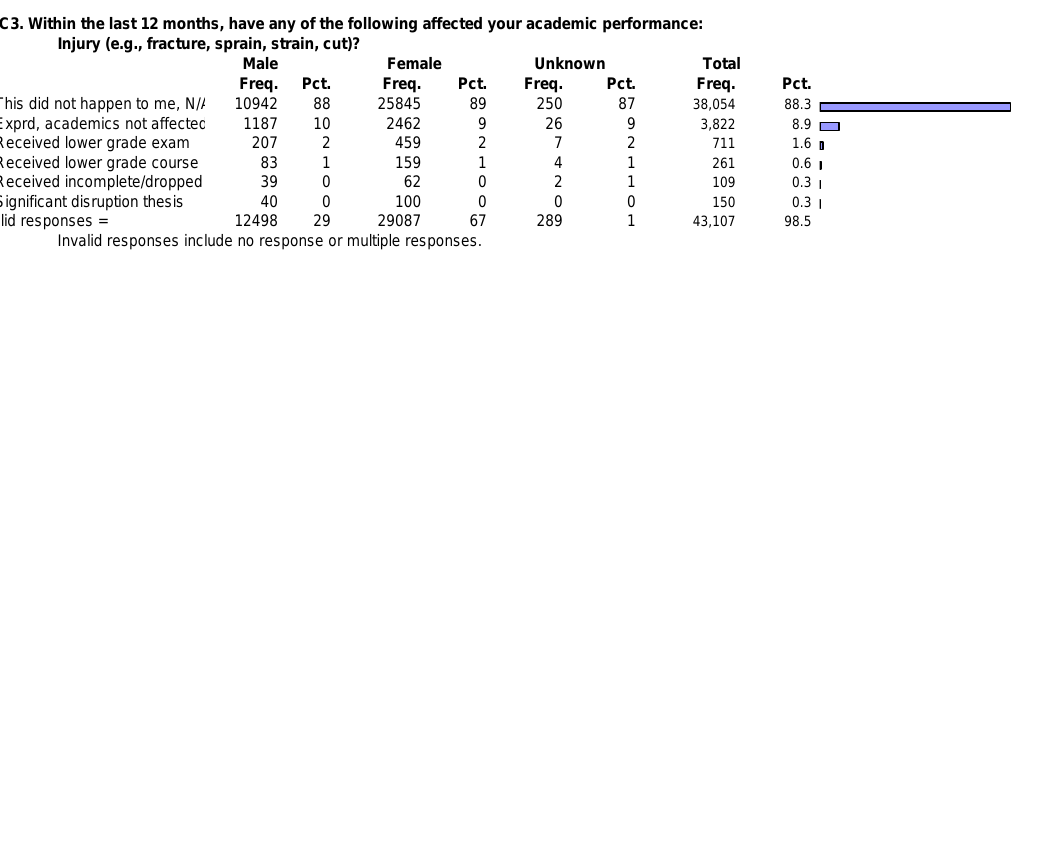
Invalid responses include no response or multiple responses.